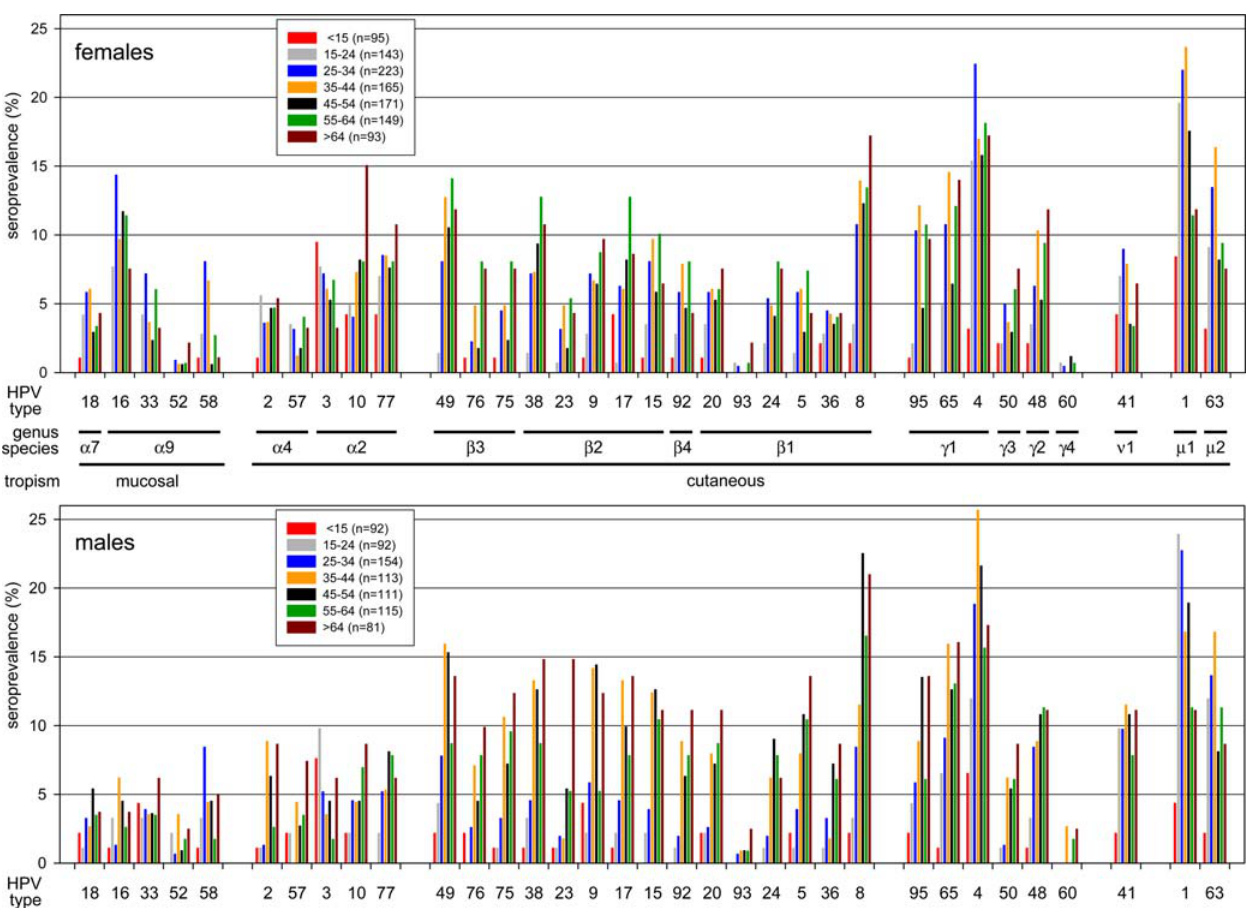
Figure 2. Prevalence of antibodies to 34 HPV types in the German population. Antibodies against HPV L1 proteins of 29 cutaneous and 5 mucosal HPV types were analysed in 1797 sera from the German general population and stratified by sex and age. The type-specific seroprevalences in seven age groups are shown for females and males separately. Colour code, age groups in years and size of the groups are indicated in the inserts. HPV types are specified below each graph, and genus, species, and tropism are shown between the graphs. Seroprevalence patterns were similar for m and n PV, for high-risk mucosal a PV in females, and for b and c PV, respectively. Antibodies to cutaneous m and n PV were already present in children with substantial prevalences in young adults (15–24 years). Antibodies to mucosal high-risk HPV appeared after puberty and peaked in the 25–34 years group mainly in women. Seroprevalence for b and c PV accumulated and peaked late in life in both genders. Most HPV showed two seroprevalence peaks. Age at the first peak varied from about 20 to 50 years for the different genera, but the second prevalence peak rather uniformly occurred at old age, in females at about 60 years and in males at above 64 years.